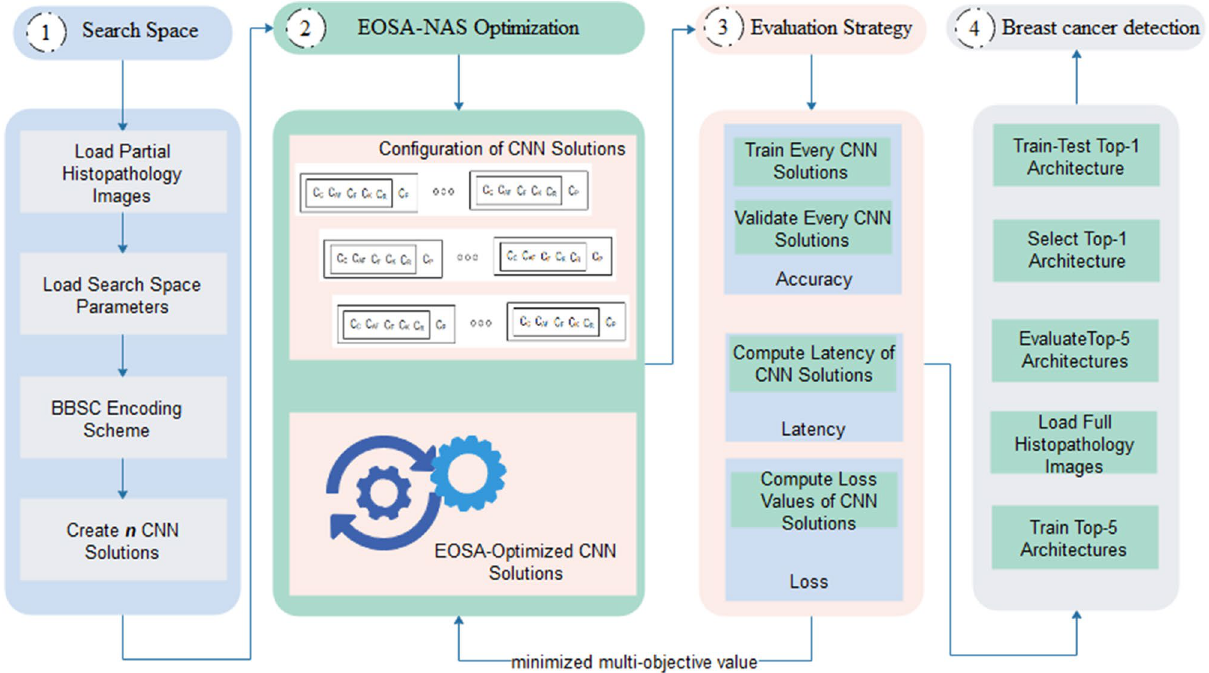
Figure 1. The proposed EOSA-NAS model consisting of four components: the search space, EOSA-NAS search strategy, evaluation strategy and the breast cancer detection module using the top-5 and top-1 CNN